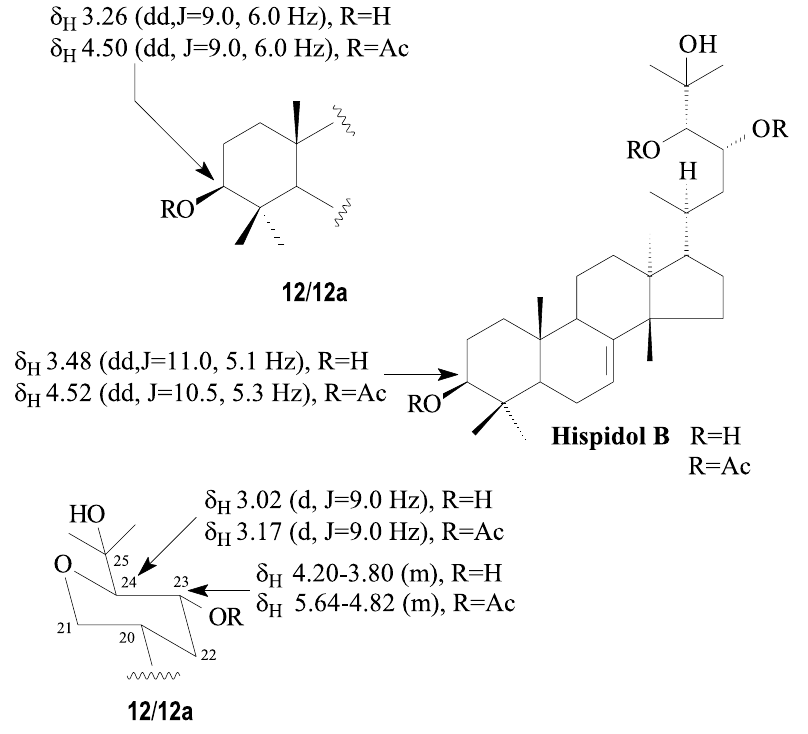
Fig. 4 – Comparison of the 1 H chemical shifts of H-3 of 12 and 12a with the corresponding values for hispidol B and its acetyl derivative reported in the literature (Jolad et al. 1981. The coupling constant ( J = 9 . 0 Hz) observed for signals of 12 and 12a reveal an axial-axial interaction between H-24 and